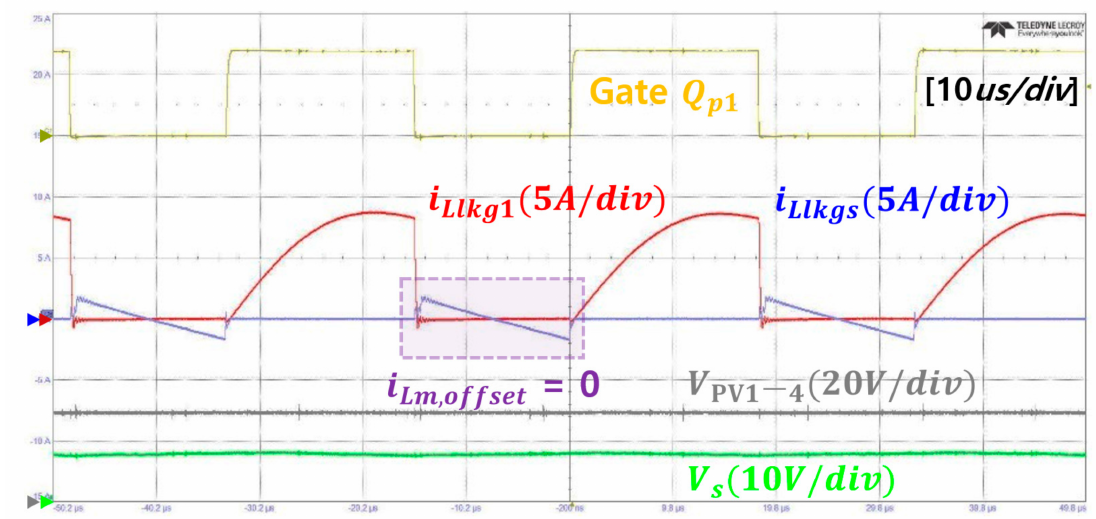
Figure 12. Experimental key waveform of the magnetizing current of an integrated